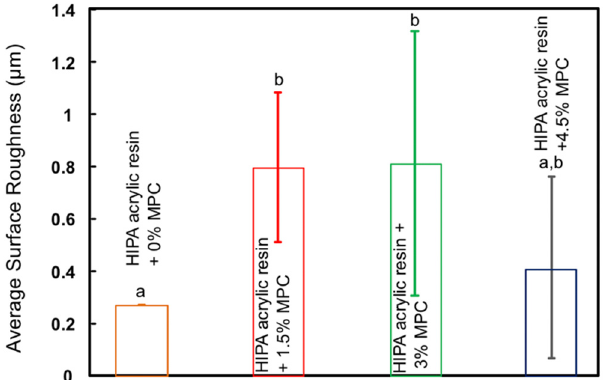
Figure 1. Average roughness values of high impact denture acrylic (HIPA) resin mixed with 0%, 1.5%, 3%, and 4.5% % 2-methacryloyloxyethyl phosphorylcholine (MPC) as a protein repellent (mean ± SD; n = 12). HIPA resin with 4.5% MPC showed surface roughness values similar to that of the control group ( p > 0.05).